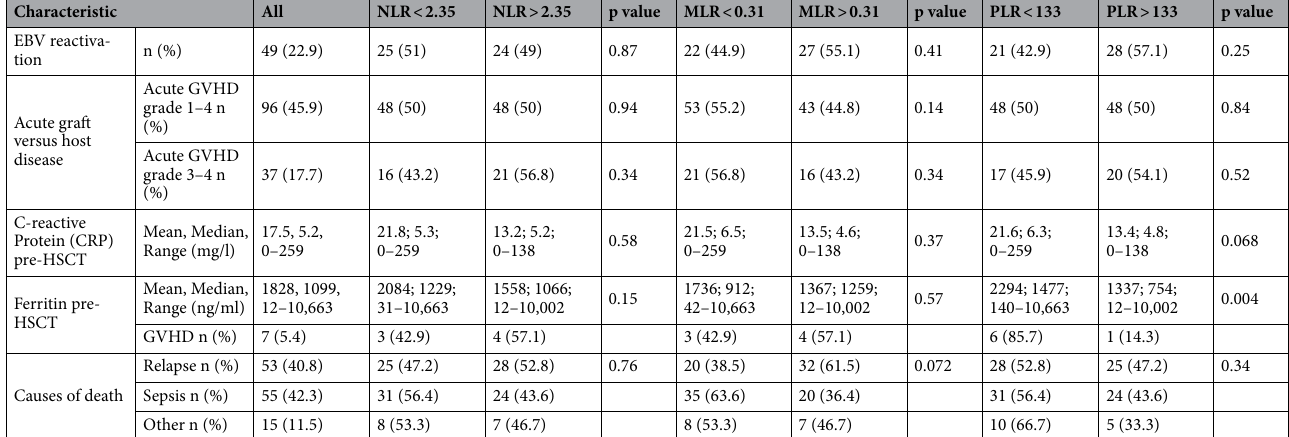
Table 1. Patient demographic and clinical characteristics.